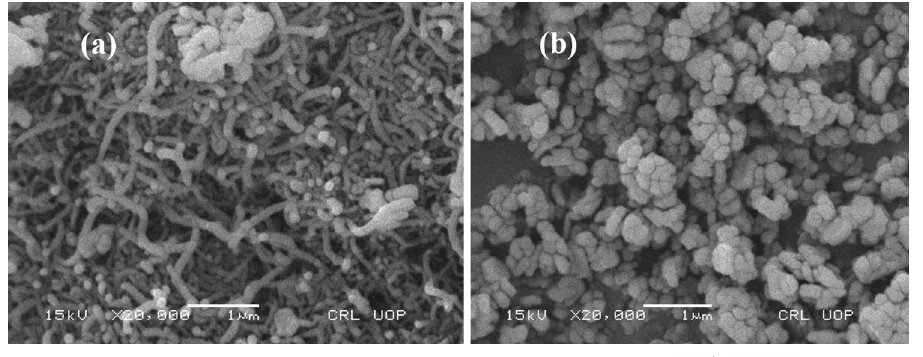
Fig. 2 SEM images of a F-MWCNTs/Co–Ti oxides and b Co–Ti oxide